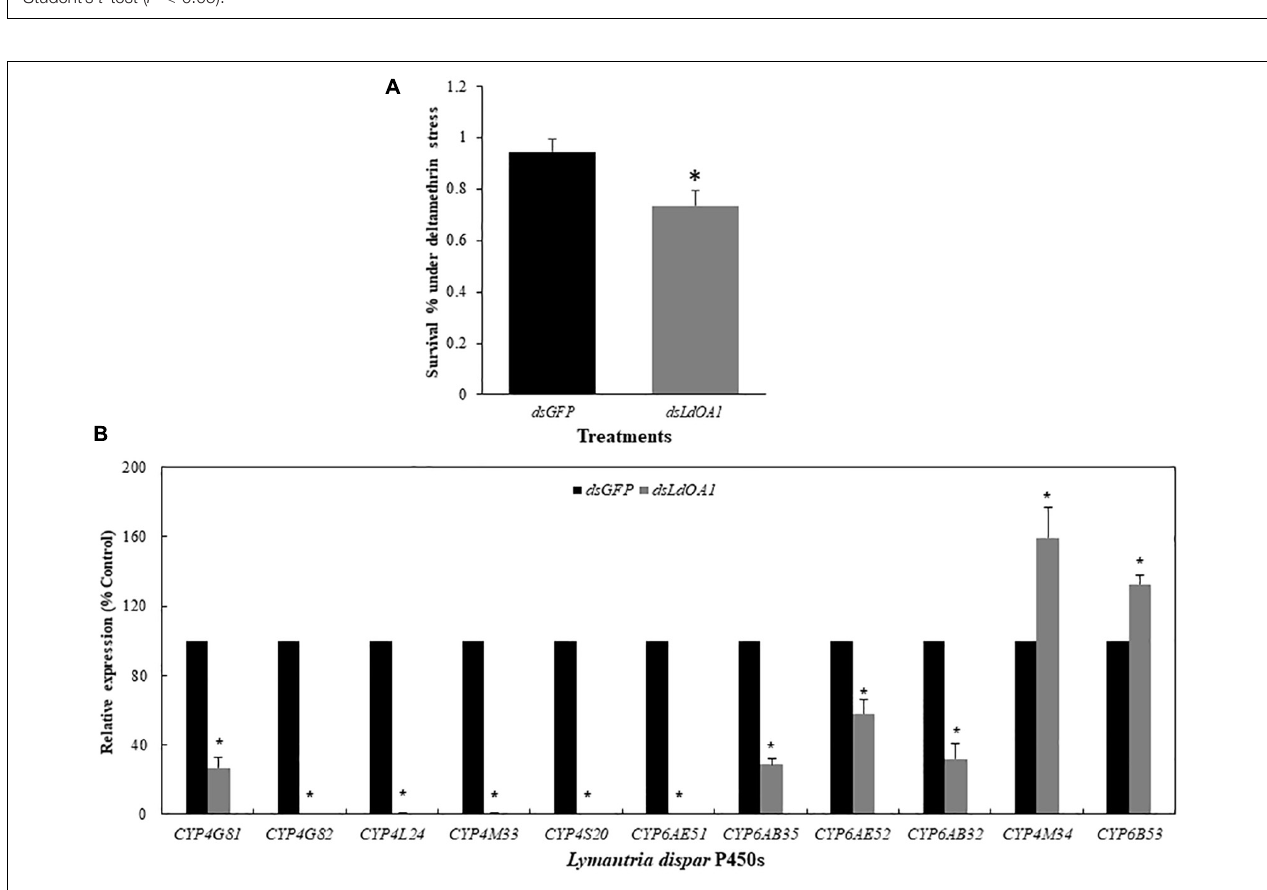
FIGURE 3 | Effects of sublethal deltamethrin (24 h LC 20 = 15 mg/L) on 3 rd instar L. dispar larvae survival (A) and CYP gene expressions (B) 120 h after injecting dsRNA of green fluorescent protein ( GFP , control) or dsRNA of LdOA1 . The cumulative mortality of larvae in both control and treatment was recorded 5 days after the deltamethrin challenge. Steady-state CYP transcript levels were determined by qRT-PCR for GFP dsRNA-injected ( dsGFP ) and LdOA1 dsRNA-injected (ds LdOA1 ) 3 rd instar L. dispar larvae. Data were normalized to Actin , EF1 α , and TUB internal controls, and 2 − (cid:49)(cid:49) CT method was used to obtain relative expression levels, expressed as mean ± SD from assays performed in triplicate. Asterisk ( ∗ ) indicates significant differences among different treatments at the same gene by Student’s t -test ( P < 0.05).